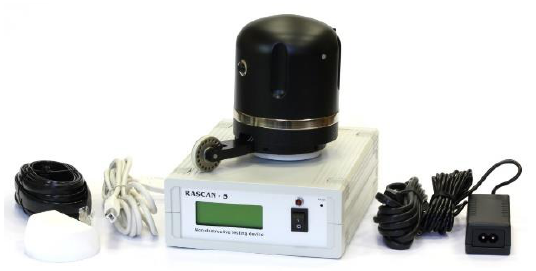
Figure 10. Holographic subsurface radar RASCAN-5 [64].